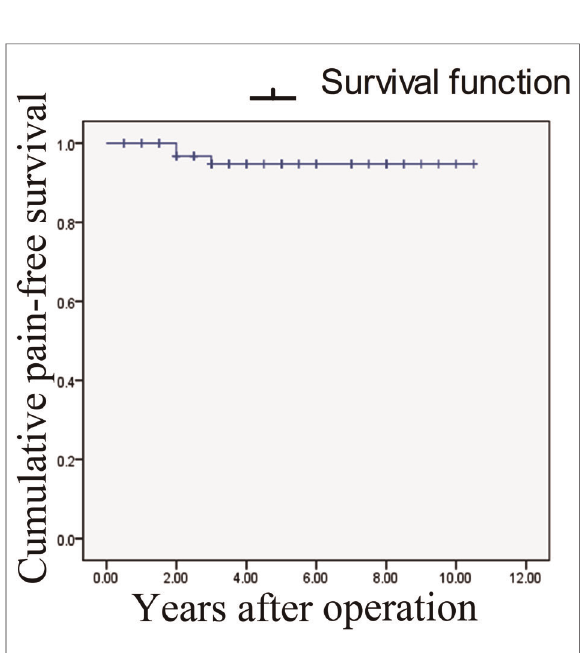
FIGURE 7 Kaplan – Meier survival pain-free analysis. Recurrence of pain occurred in three patients (at 2, 2, and 3 years post-operatively).